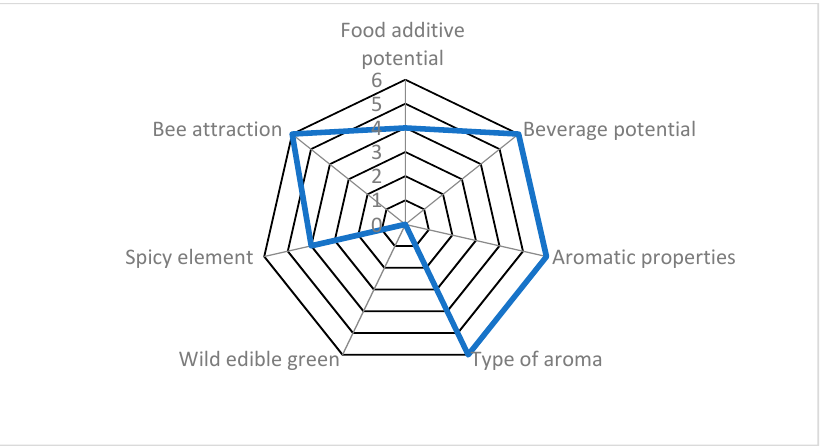
Figure 7. Evaluation example of Marrubium aschersonii (local Tunisian endemic) scored for seven agro-alimentary attributes, reaching 76.2% of the optimum possible scores. This example is hierarchically ranked in the highest (>70%) class. For attributes and scoring, see Materials and methods.